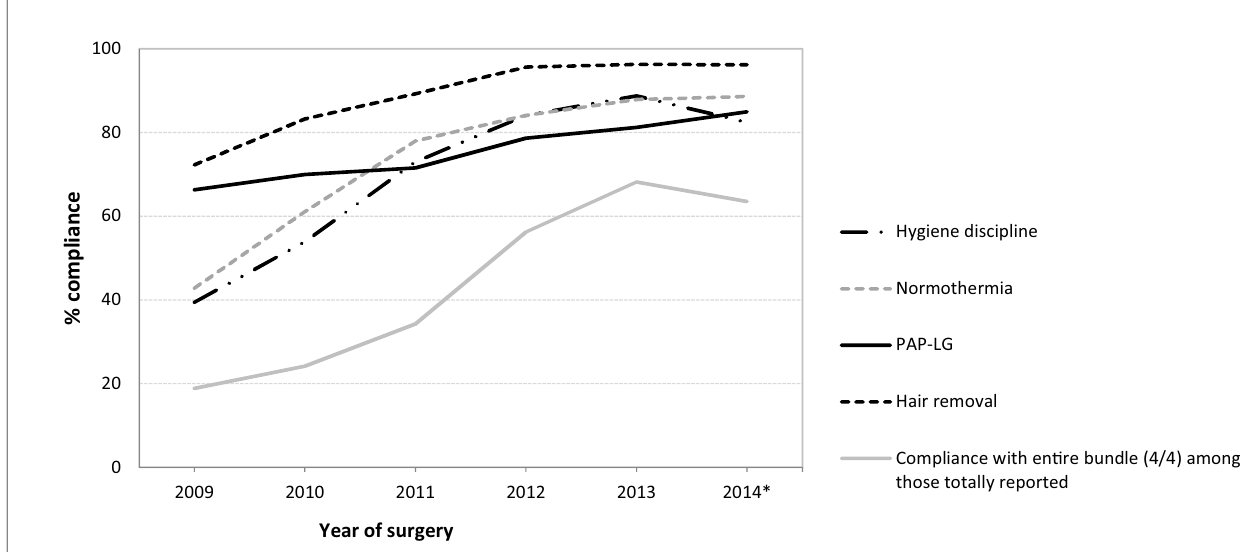
Fig 2. Compliance over time. Compliancewith the bundleelementsand with the bundleover time. Compliancewith each bundleelementwas calculatedusing surgeriesfor which the elementwas reported, i.e. not missing (n = 72 457 for hygienediscipline, n = 112 215 for normothermia, n = 130 622 for hair removal, and n = 139 089 for PAP-LG). Bundlecompliancewas calculatedwithin the group of surgeriesfor which (non-) compliancewas reportedfor the entire bundle(n = 62 486). * Data from 2014 are incompletebecauseof the mandatorydelay in follow-upof one year, which caused a delay in reporting the data. PAP-LG = Peri-operative AntibioticProphylaxisaccordingto Local Guidelines.